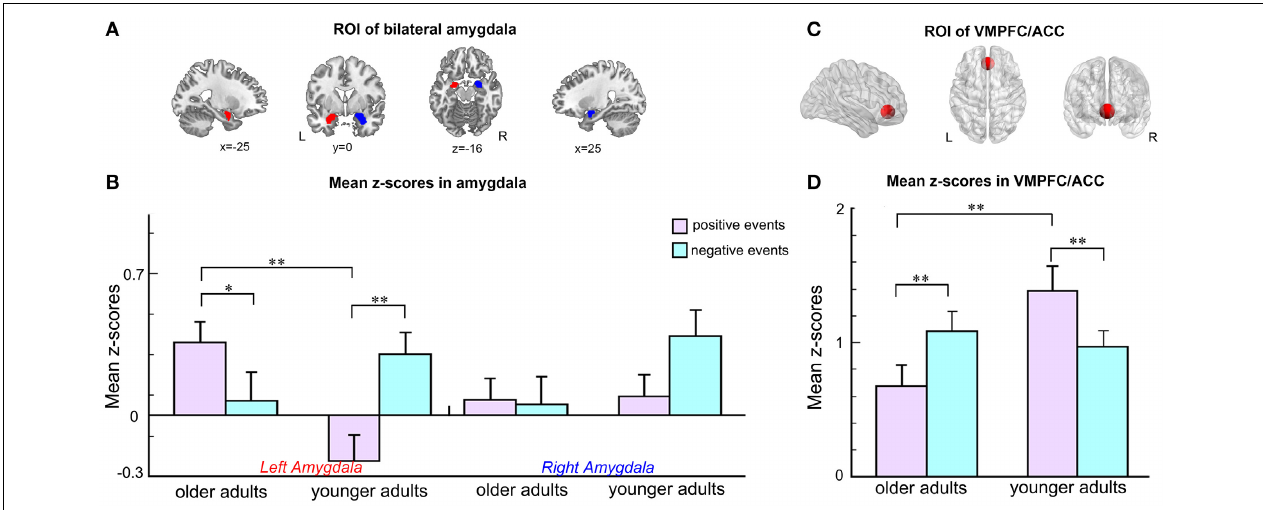
FIGURE 2 | Results of the ROI analyses for the region of the amygdala and the ventromedial prefrontal/anterior cingulate cortex. (A) Coronal, axial and sagittal views showing the anatomically defined ROIs of the left (red) and right (blue) amygdala. (B) Average z-scores within the bilateral amygdala of the two groups during the